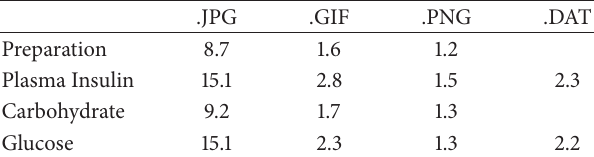
Table 2: Gives typical values for file sizes (in kb) for data and image files made displayable/accessible by the AIDA online simulator. The small file sizes help explain the rapid data transfer via the internet, and contribute to the apparent speed of AIDA online. Reducing the file sizes with .PNG files with the move to the AIDA online version 2 (AIDA online 2 ) simulator in London, UK ensured reduced bandwidth and increased apparent speed for